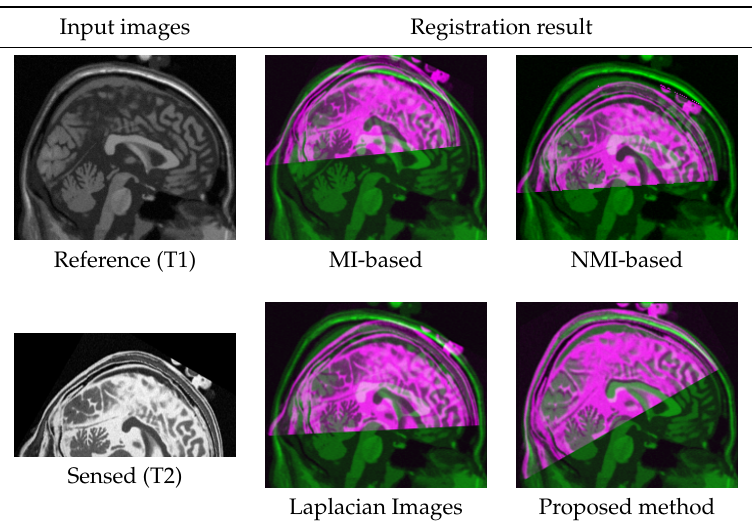
Figure 12. Registration of a synthetic example with partial data in the sensed